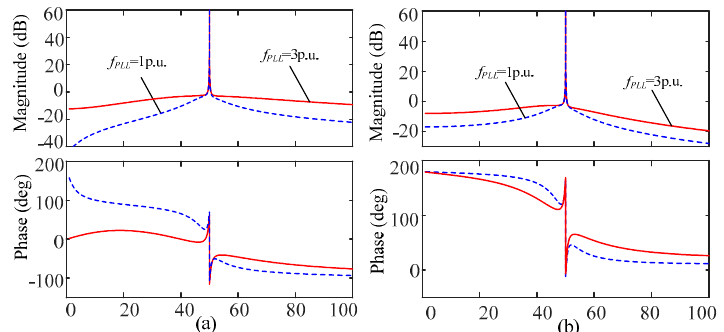
Figure 8. The frequency curves of elements in matrix G ε u ( s ) G ′ ue ( s ) with the change of PLL bandwidth: ( a ) the frequency curves of a diagonal element; and ( b ) the frequency curves of an off-diagonal element.